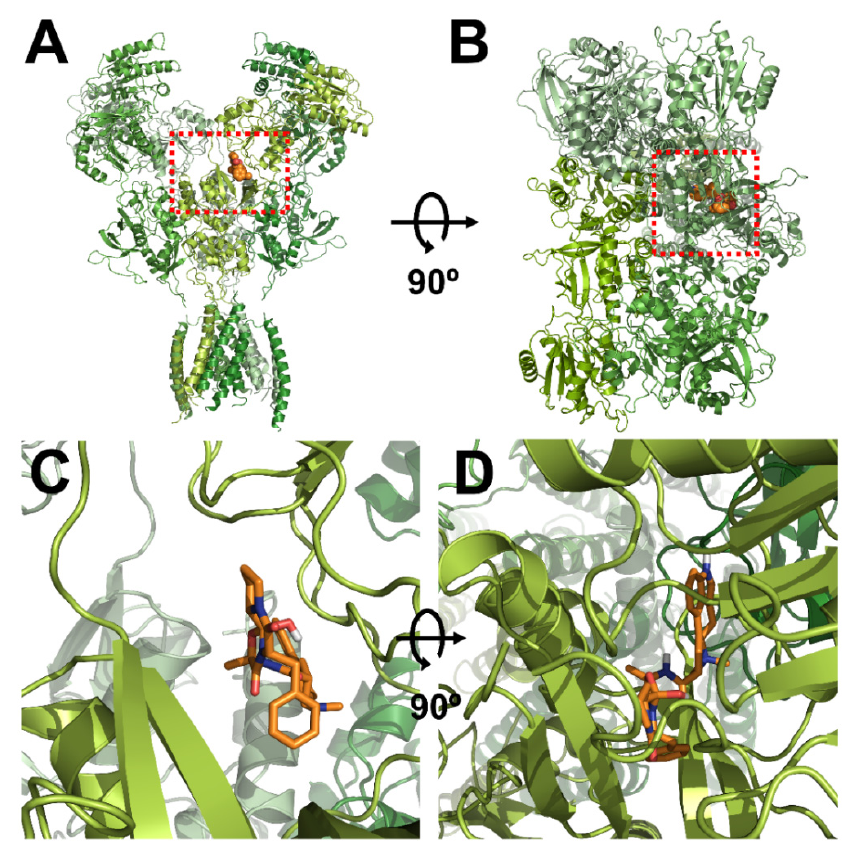
Figure 3. Computational molecular modeling of ergotamine docked to the human NR1a/NR2A receptor. ( A , C ) Side views of the docked ergotamine complex with NMDA channel. ( B , D ) Binding pocket and docking results of ergotamine and NMDA channel, respectively.